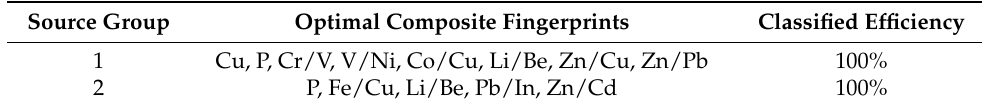
Table 6. Summary of the stepwise DFA results of two selected source